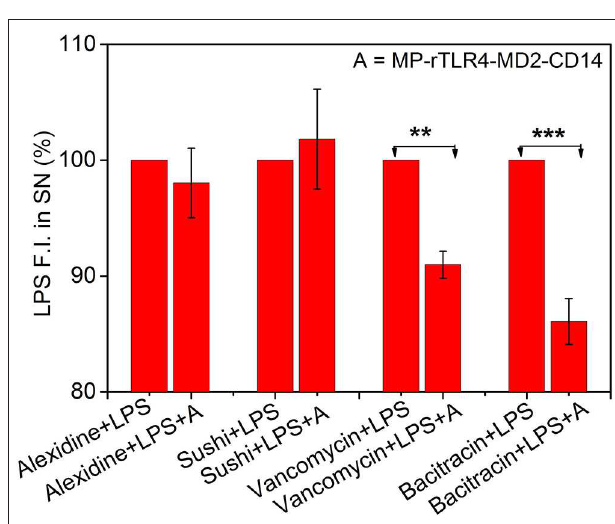
FIGURE 5 | Inhibitory ligand screening. Results shown for LPS-interacting alexidine and sushi molecules used as test, and LPS-non-interacting bacitracin and vancomycin molecules used as control ( n = 3). While the LPS fluorescence intensity in the SN remained constant upon addition of MP-rTLR4-MD2-CD14 assay mix (marked here as “A”) in the presence of alexdine and sushi, it reduced significantly with bacitracin and vancomycin suggesting the inhibitory potential of the first two molecules for obstructing rTLR4 pathway. All the data have been normalized with respect to the fluorescence intensity before “A” addition. The concentrations of each ligand used in reaction was 2.4 µ M in their respective reactions (SN = supernatant, ** p = 0.001–0.01, *** p <